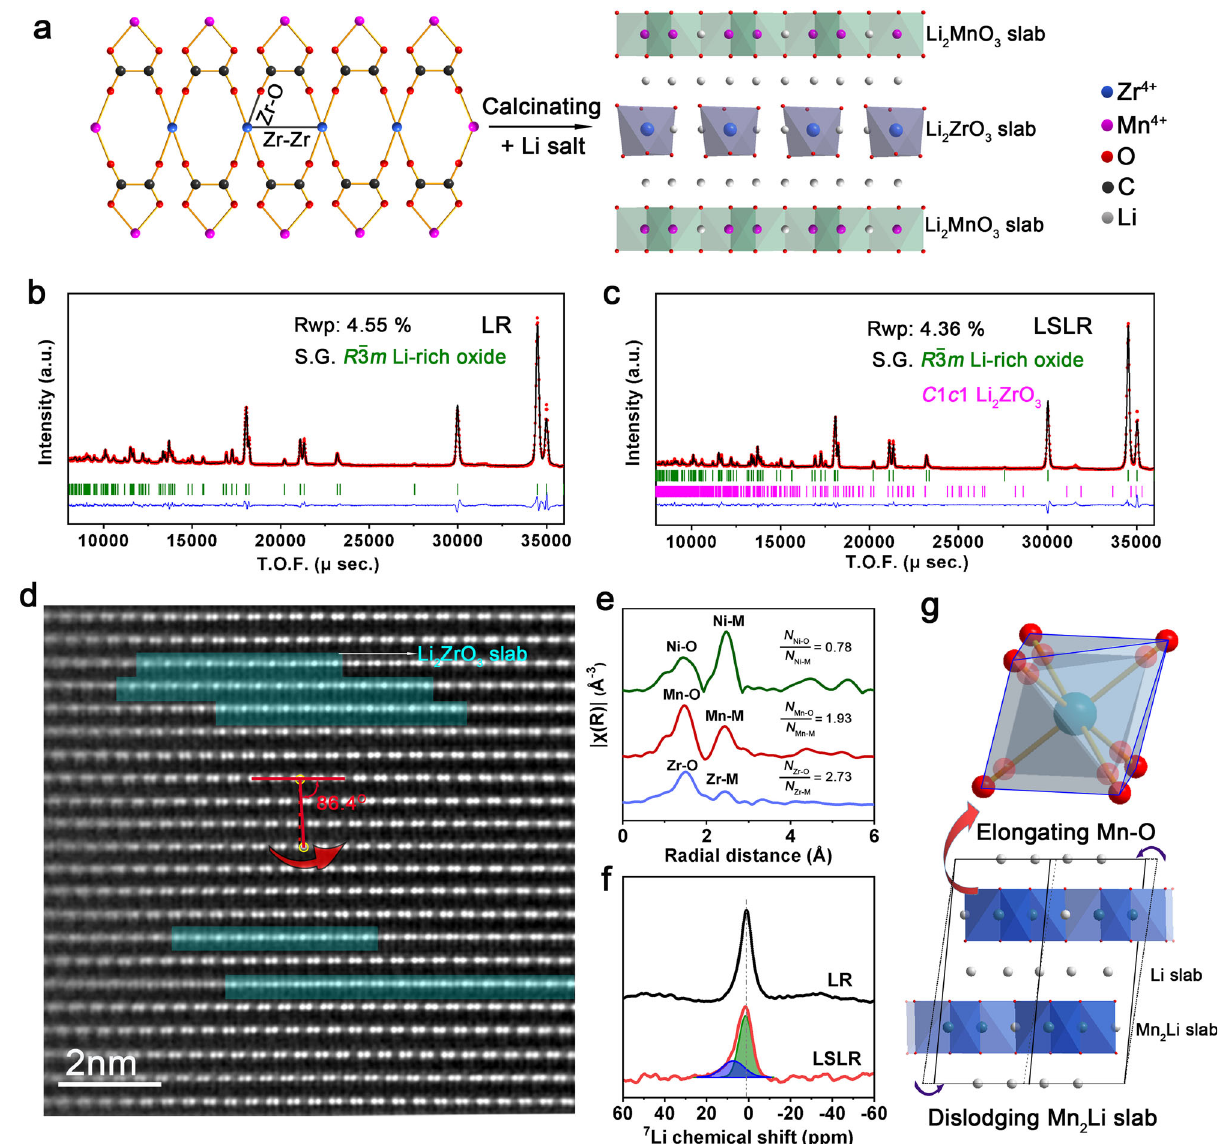
Fig. 1 Structural properties of LSLR. a Schematic procedure to synthesize LSLR. b , c Rietveld re fi ned neutron diffraction patterns of LR ( b ) and LSLR ( c ). d AC-STEM image of LSLR observed along the [110] axis. e Fourier-transformed Ni/Mn/Zr K-edge EXAFS. N is the coordination number. f 7 Li MAS-NMR spectra for LR and LSLR. g Schematic illustration of the proposed structure for the Li 2 MnO 3 domain in LSLR. Source data are provided as a Source Data fi